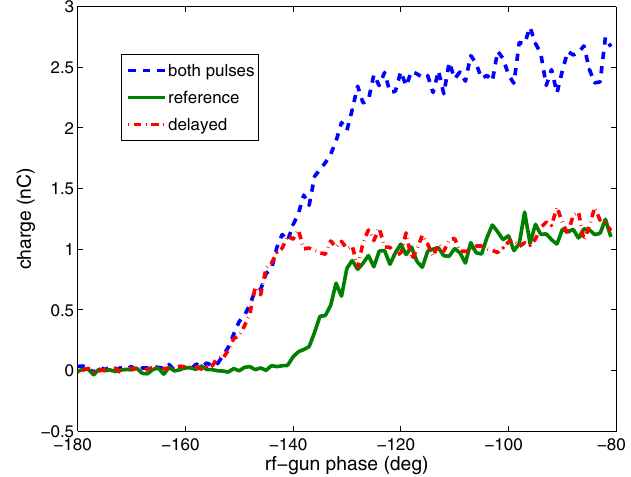
FIG. 3. (Color) Scan of the phase between the rf gun and the photocathode drive laser when only reference (delayed) or both uv pulses are incident on the photocathode. The data were obtained with the same uv-pulse configuration as in Fig. 2. The horizontal axis has an arbitrary